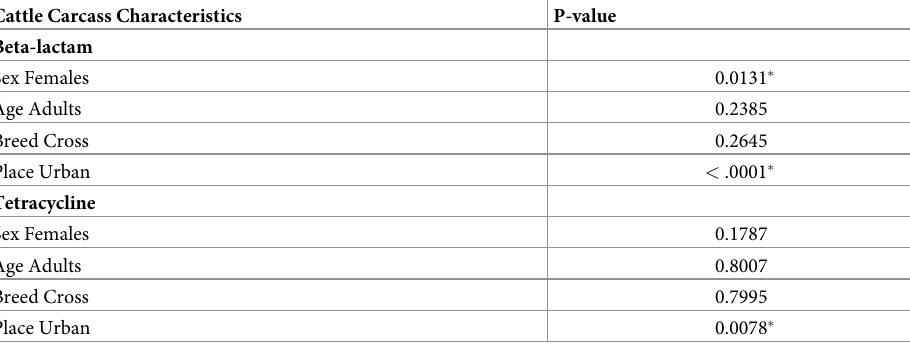
Table 5. Estimates obtained from proportional odds